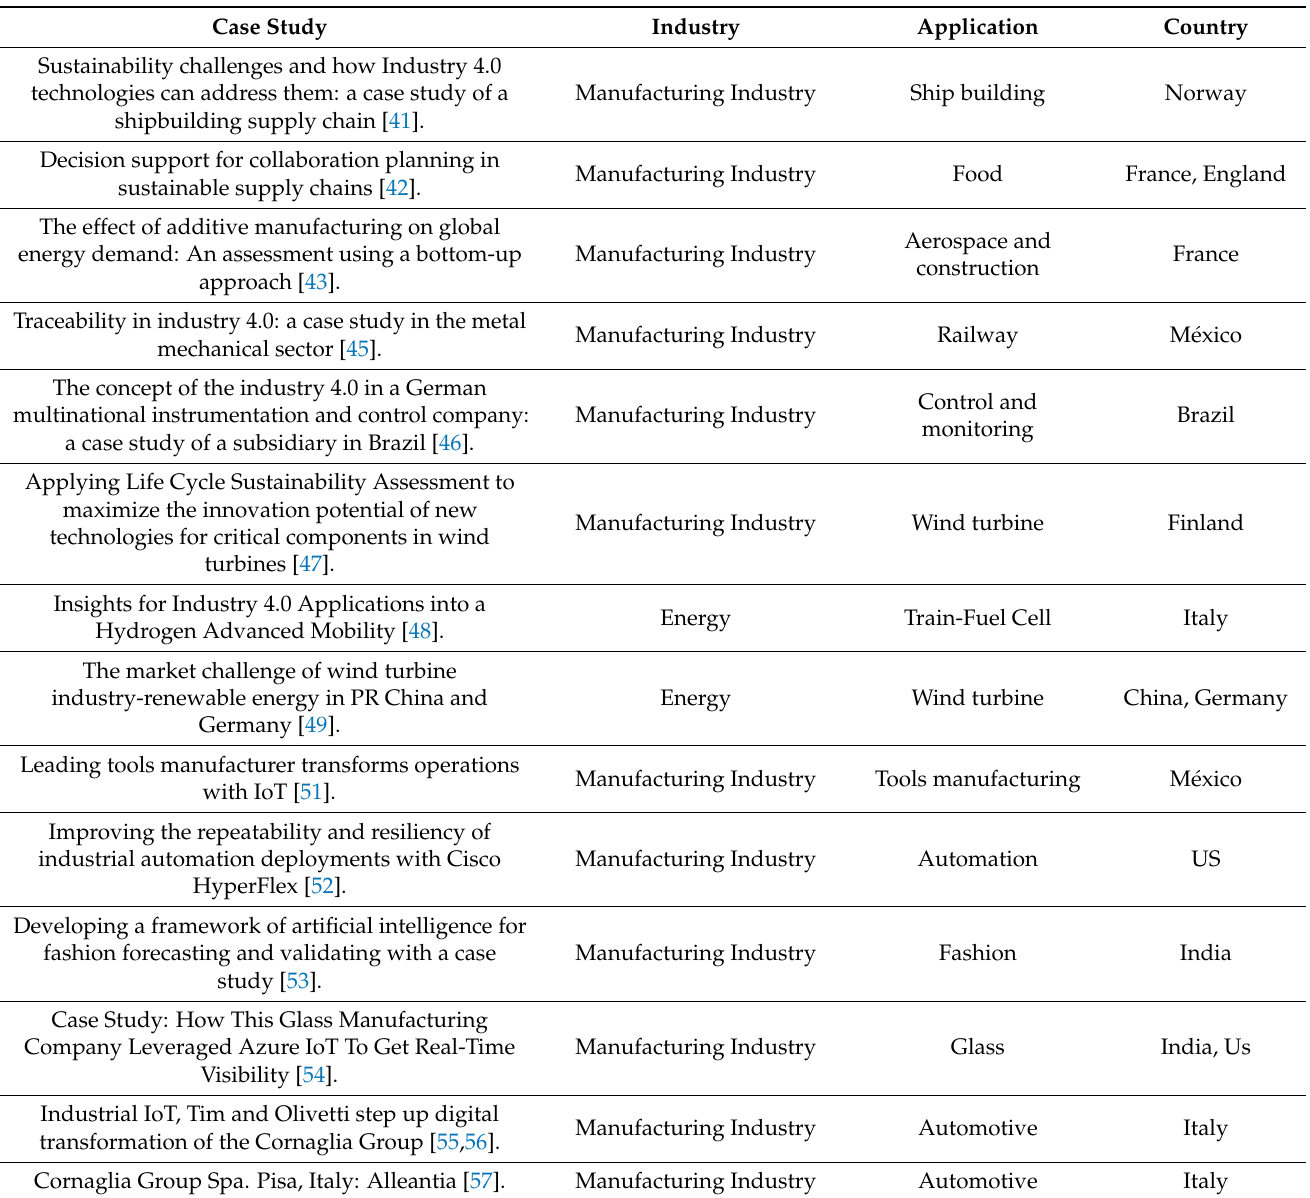
Table 2. Summary and information of case study: economic